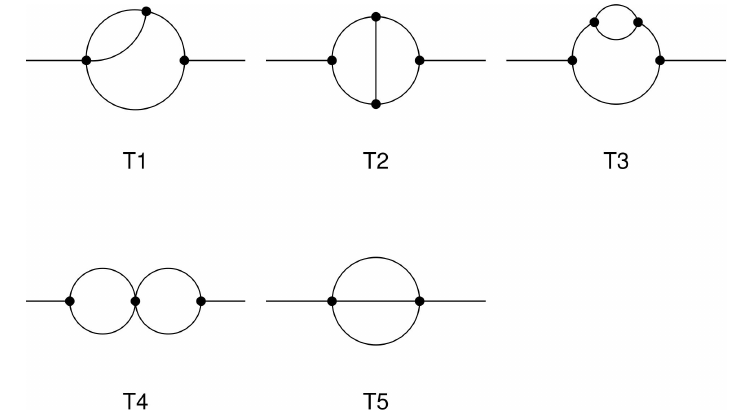
Figure 1: Two-loop topologies for two-point